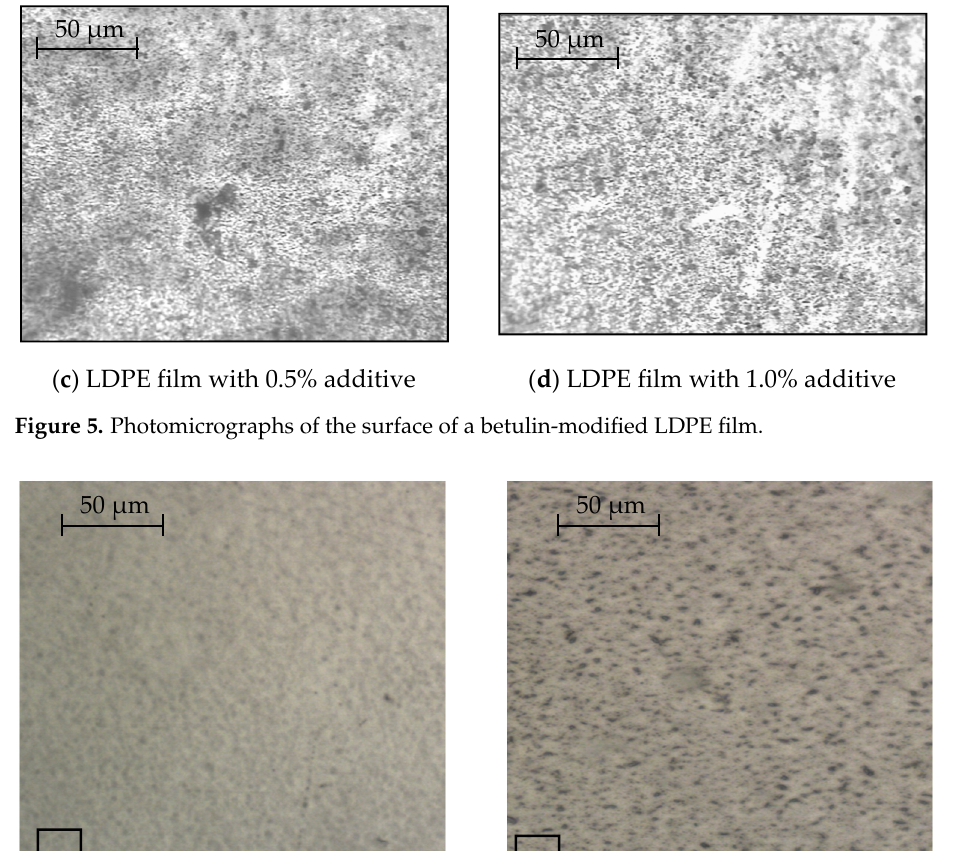
Figure 6. Surface microstructure of modified PA/LDPE film: ( а ) РА /LDPE (control), ( b ) РА /LDPE (0.5% additive in polyethylene layer).